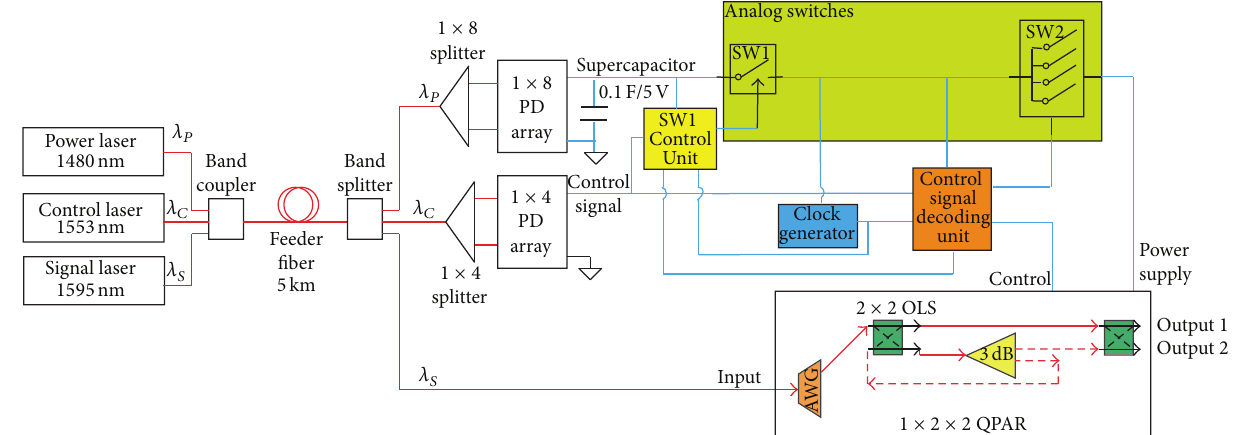
Figure 13: Testbed of the 1 × 2 × 2 QPAR remote power and reconfiguration.